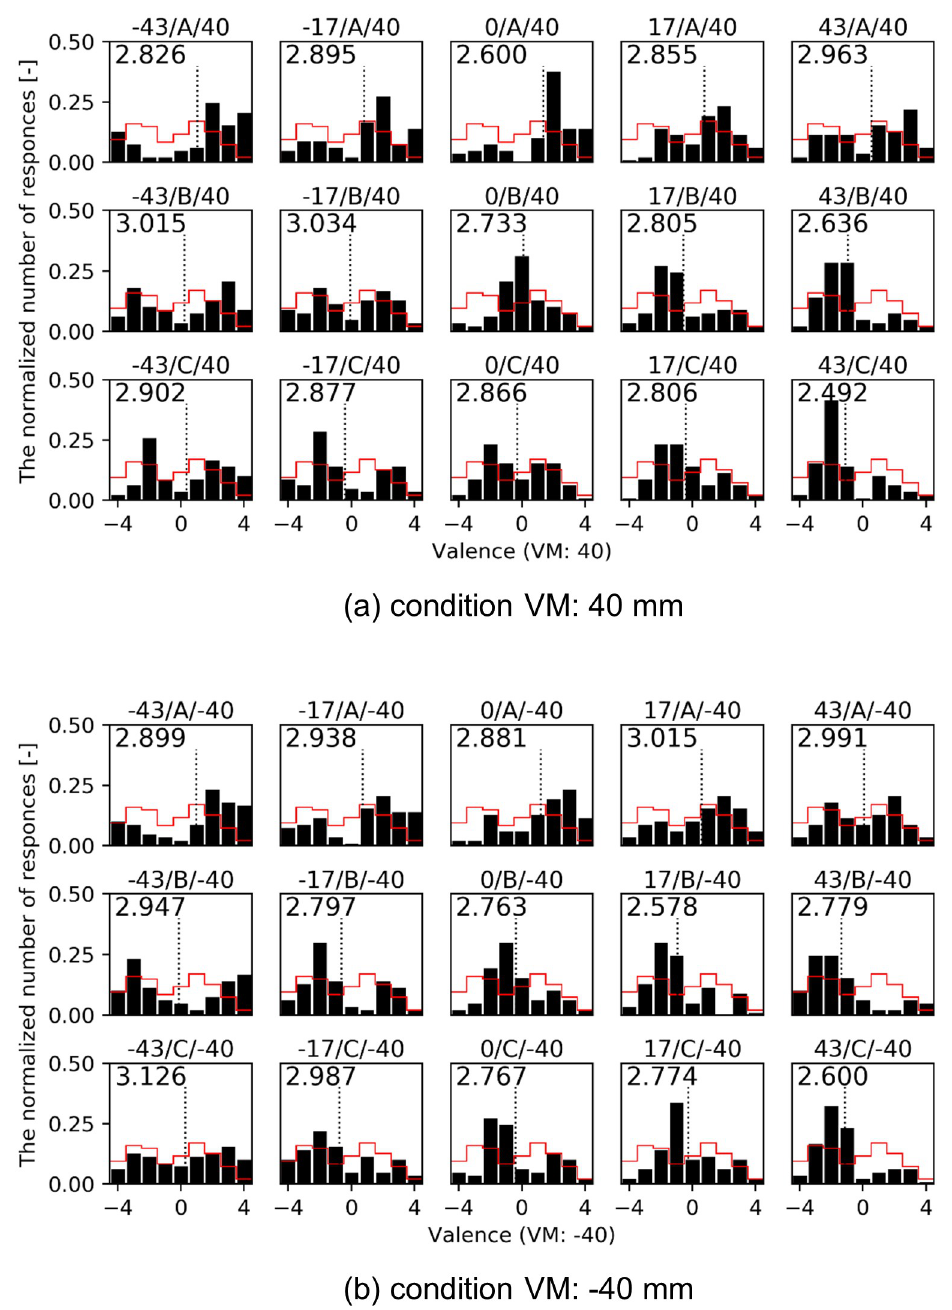
Fig 9. Distributions of the assessed facial valence in Experiment 3. The horizontal axis shows the facial valence as assessed by participants and the vertical axis shows the normalized number of answers at each movement. The dotted line shows the mean facial valence. The red line on the histogram shows the result of intense facial expression in Experiment 1 as a reference. The entropy is shown in the upper left of each histogram.